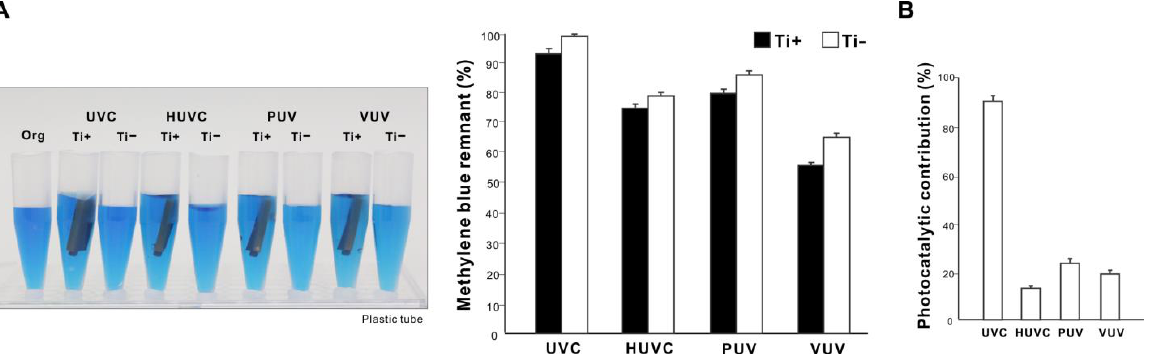
Figure 6. UV-mediated decomposition of methylene blue in plastic tubes. ( A ) Photographs of the original methylene blue solution in a laboratory-grade plastic tube together with solutions after UV treatment presented side-by-side for comparison. Four different UV light sources were used for one minute, as in Figure 3. UV treatment was conducted with or without a microroughened titanium specimen. A histogram showing remnant methylene blue after UV treatment (%). ( B ) Photocatalytic contribution (%) calculated as the difference in the amount of decomposed methylene blue with and without a titanium